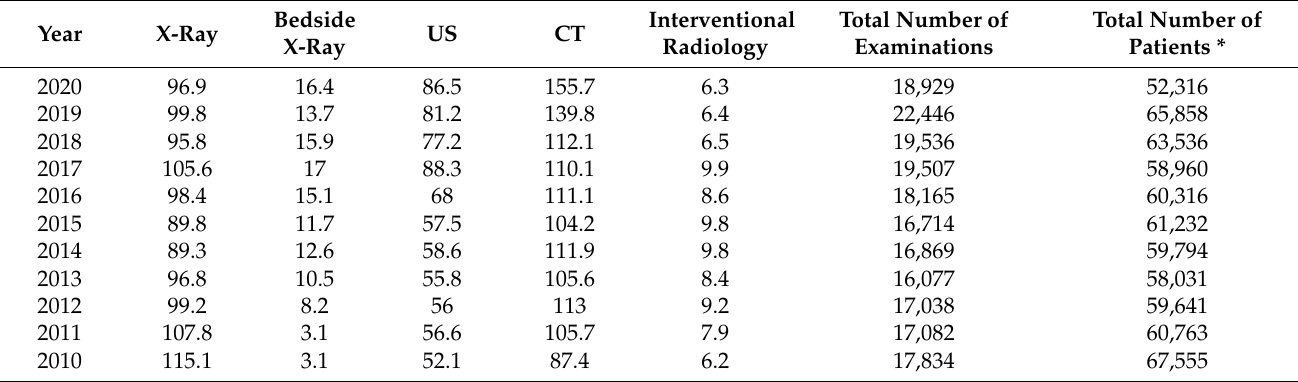
Table 1. The sum of the different types of examinations per 1000 patients performed yearly during 2010–2020. The years are presented in descending